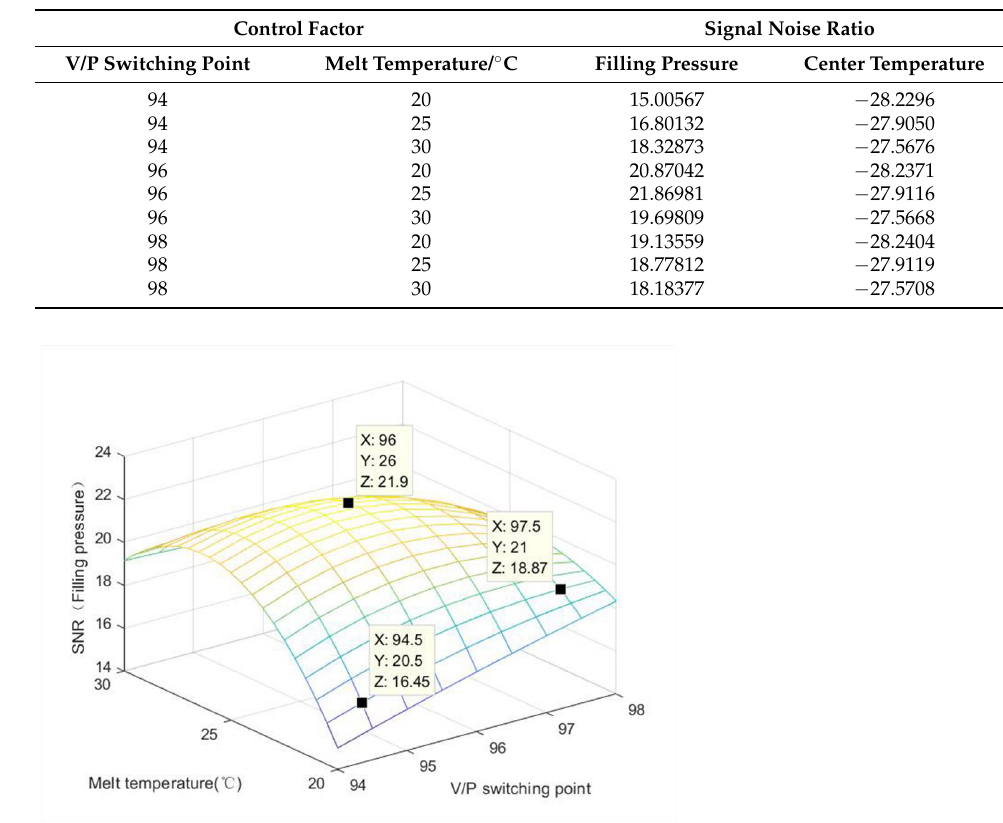
Table 5. Control factor and signal-to-noise ratio.